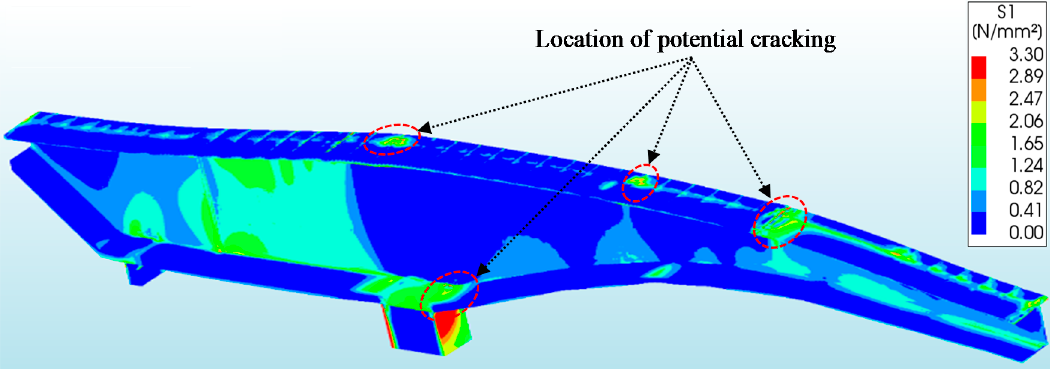
Figure 20. Variation of mid-span deflection with time of Koror–Babeldaob Bridge.